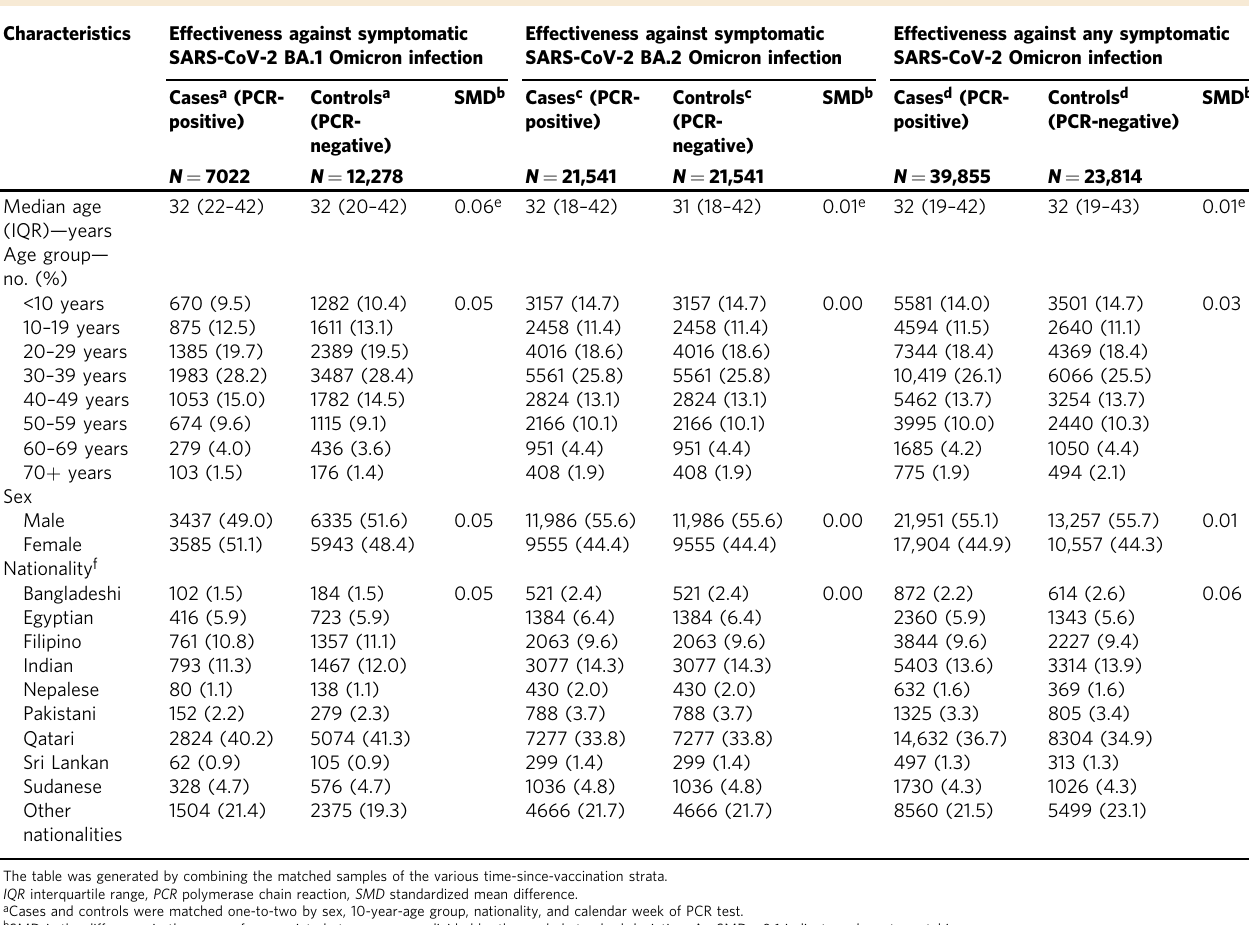
Table 1 Demographic characteristics of cases and controls in samples used to estimate effectiveness of the BNT162b2 vaccine against symptomatic SARS-CoV-2 BA.1 Omicron infection, symptomatic BA.2 Omicron infection, and any symptomatic Omicron infection.